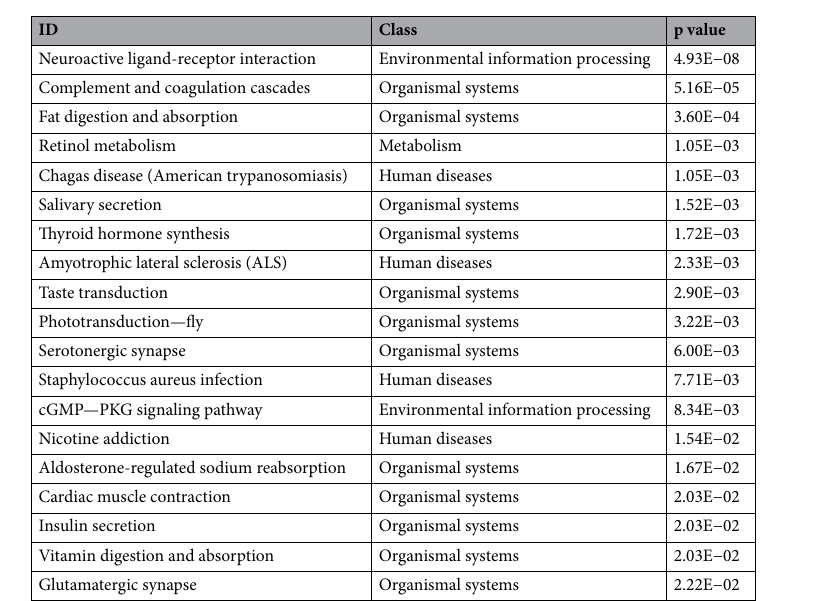
Table 3. The KEGG analysis of the significantly differentially expressed